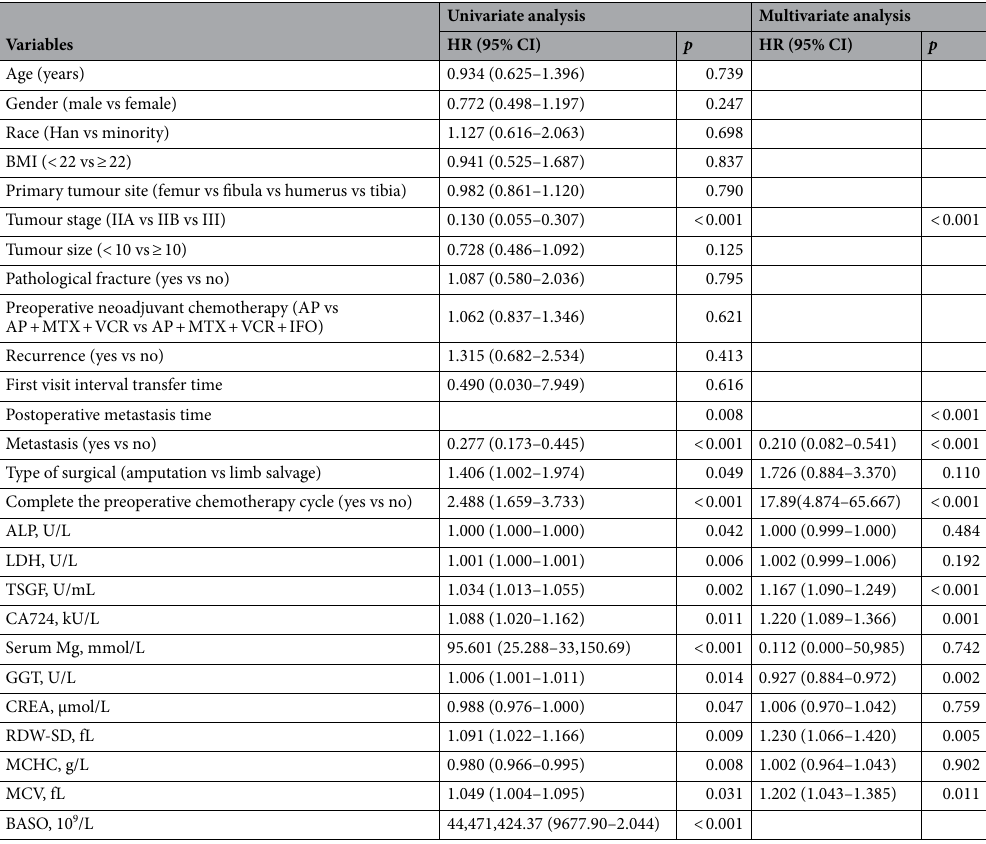
Table 2. Univariate and multivariate Cox proportional hazards regression analysis for the risk factors associated with the survival of HOS patients. HR hazard ratio, CI confidence interval.